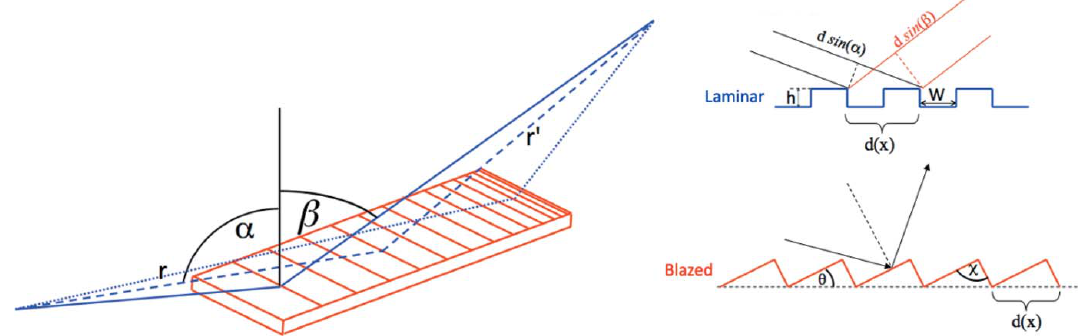
Figure 1 Left: convention used for the angles of incidence and diffraction. Right: pictorial description of the laminar and blazed gratings with relative nomenclature. d ( x ) is the period. (cid:3) and (cid:4) are the angles of incidence and diffraction, respectively, considered positive with respect to the normal. h is the groove depth for laminar gratings and W is the groove width. (cid:5) is the blaze angle and (cid:6) the apex angle. r is the source-to-grating distance and r 0 is the grating-to-focus